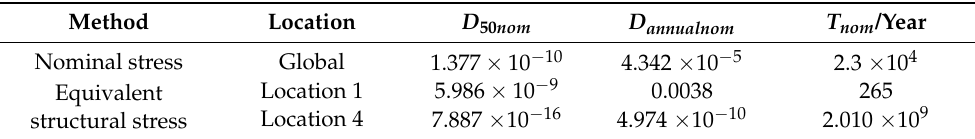
Table 8. Fatigue assessment using different